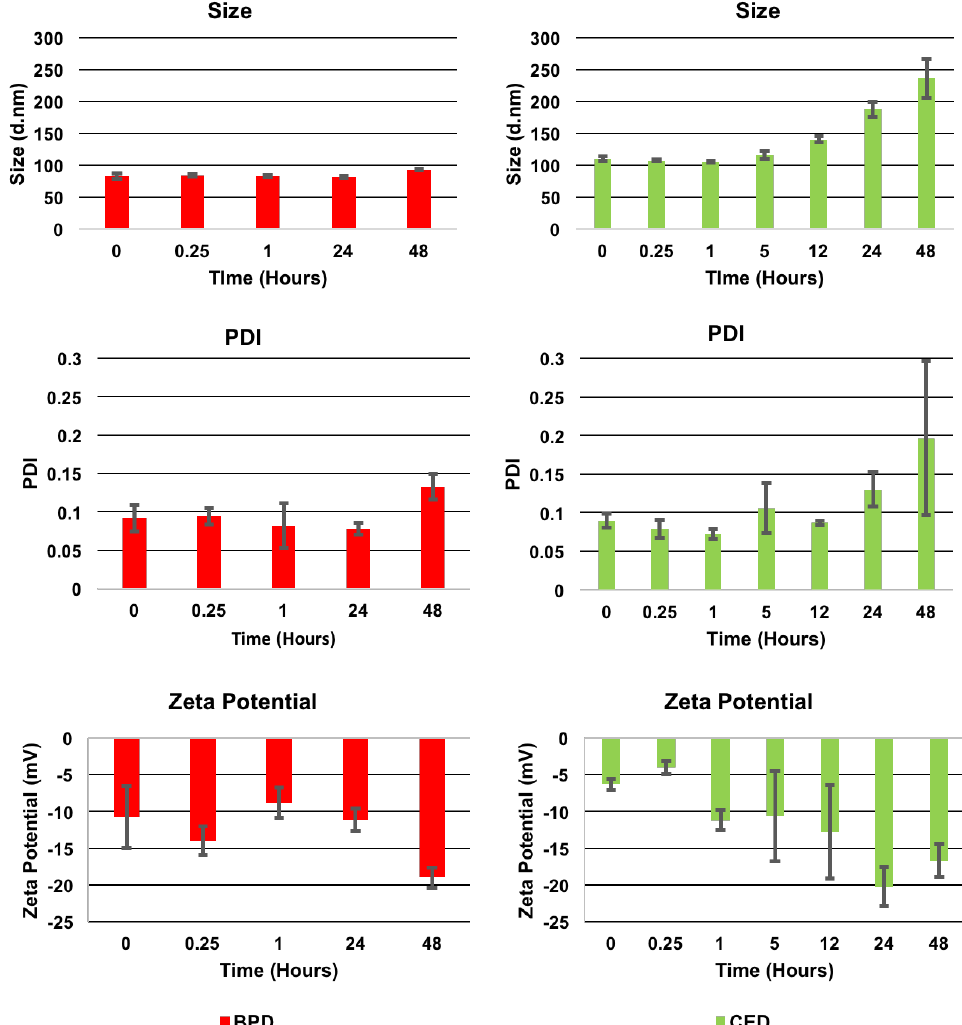
Figure 3. Stability study results (Size ( top ), PDI ( middle ), and Zeta Potential ( bottom ) for BPD ( left ) and CED ( right ) NPs over a 2-day period in media at 37 °C. Additional time points for CED NPs can be found at 5 and 12 h to show the gradual increase in size as NPs became unstable in media. Figure S5 in supplementary documentation also shows SEM imaging of CED NPs at 24 h to support the large size increase. Samples were tested in triplicate for reproducibility.